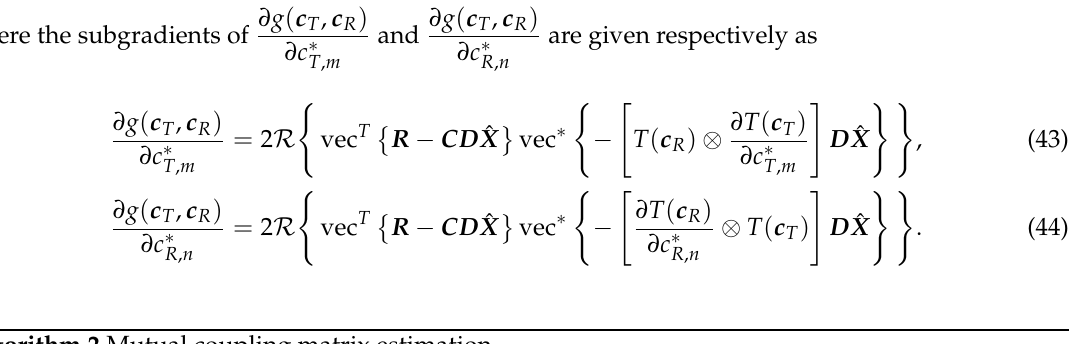
Algorithm 2 Mutual coupling matrix